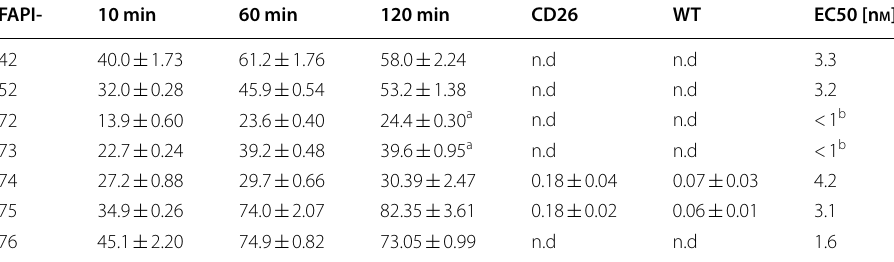
All values except EC 50 values are given in percent of applied dose on 1 million cells (%AD/10 6 cells) with standard deviations. a Measurement at 90 min. b Out of confidence